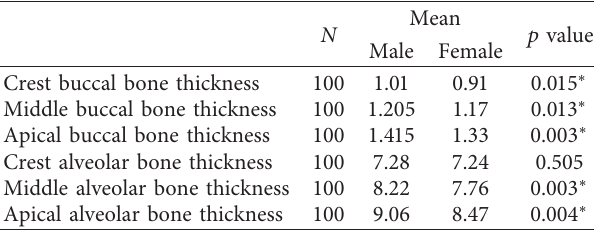
Table 4: T -test of bone thickness (mm) between males and females according to